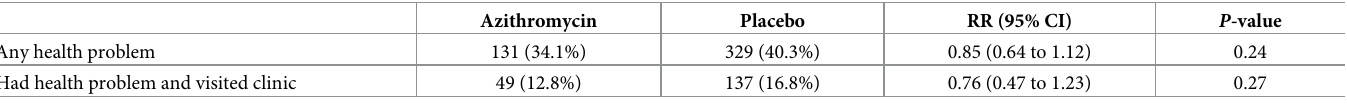
Table 2. Healthcare visits following treatment among infants aged 1–5 months receiving treatment (N =